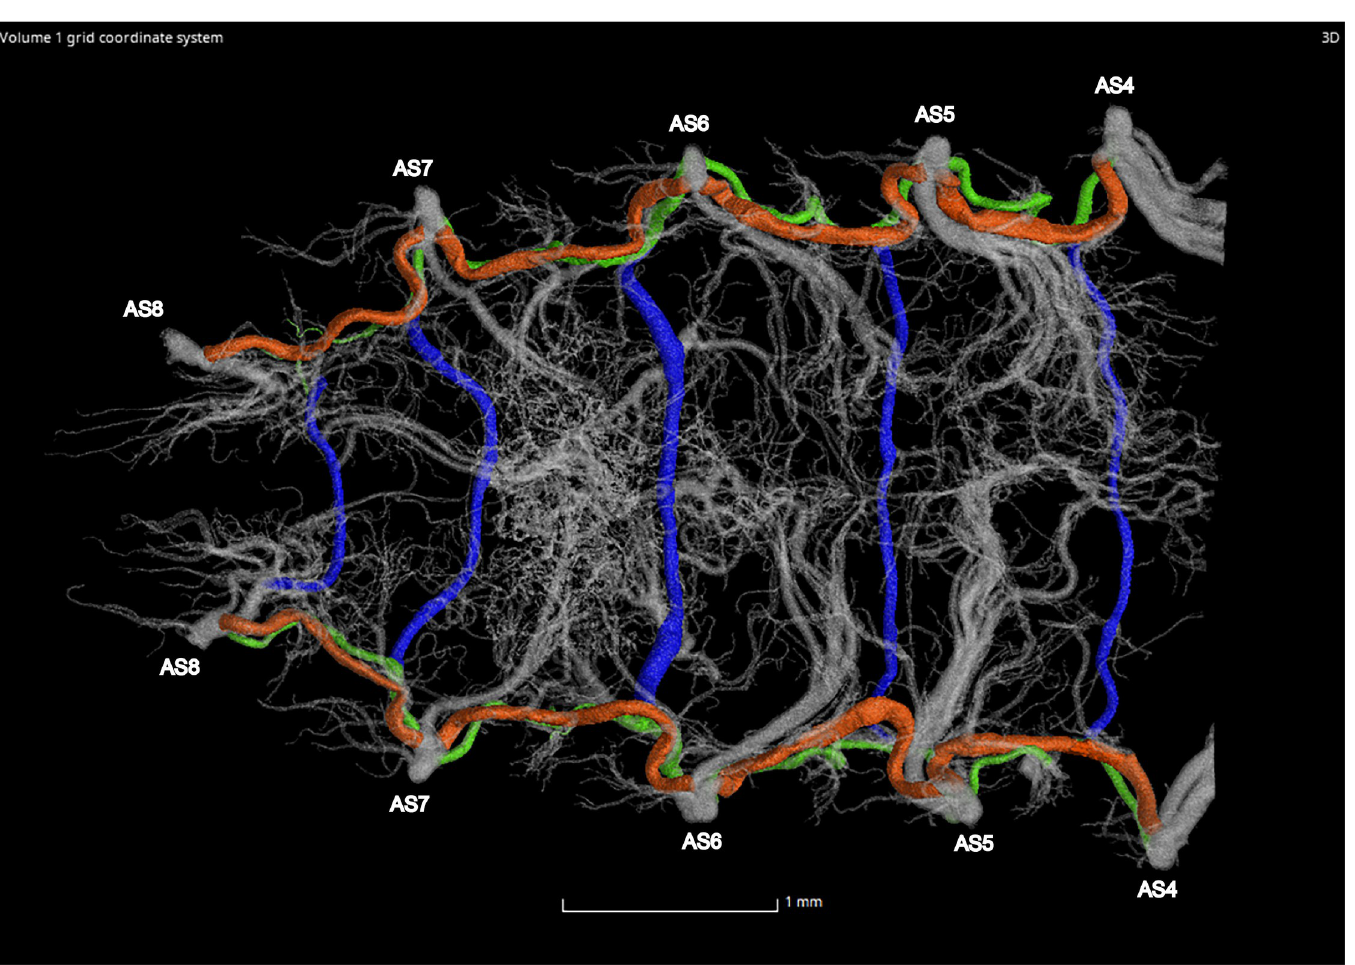
Fig 25. Dorsal view of the adult female Photinus pyralis tracheal system. Ventral commissures (VC; blue), dorsal longitudinal trunks (DLT; orange), and ventral longitudinal trunks (VLT; green) highlighted for volumetric